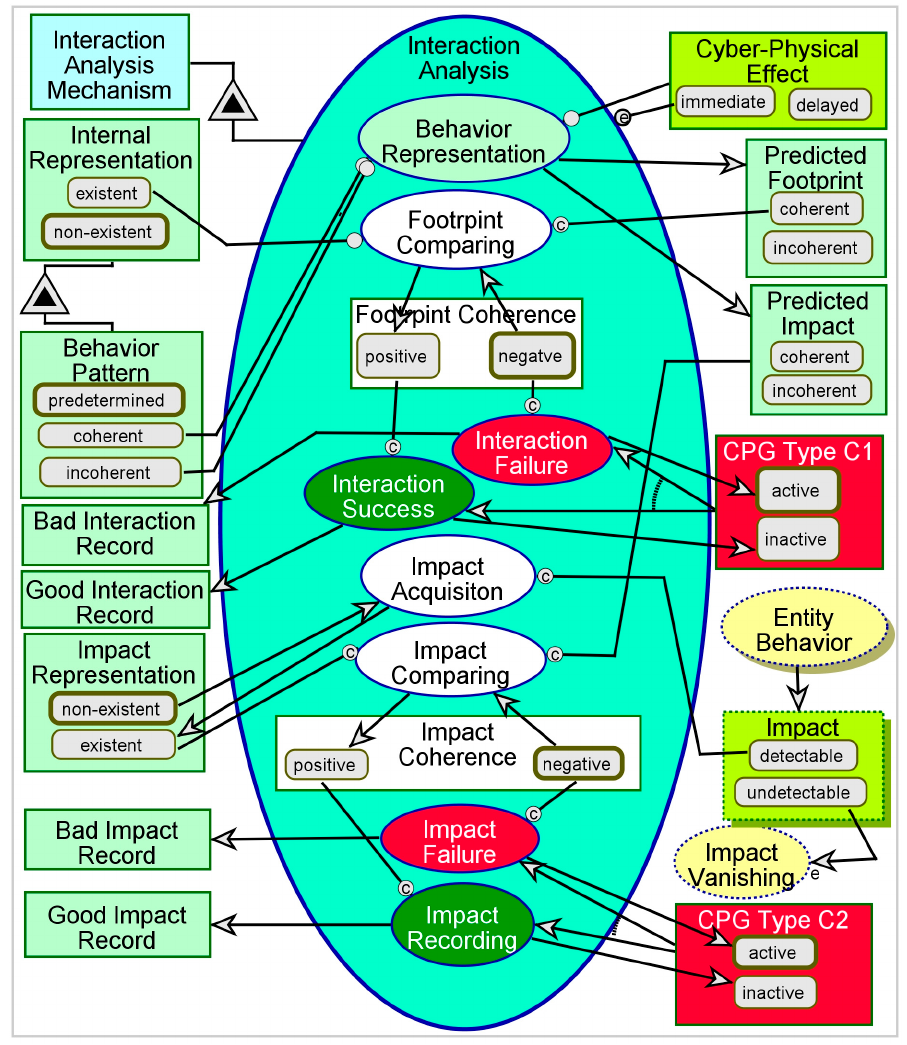
Figure 7. The Interaction Analysis process.